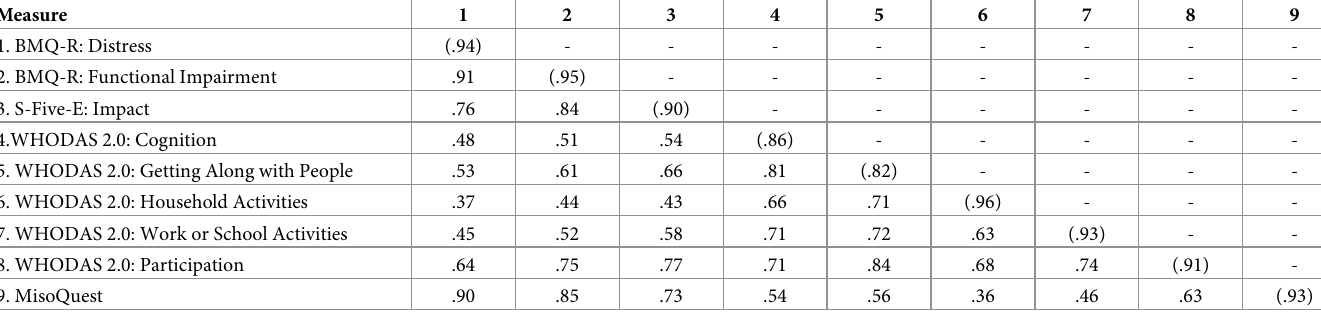
Table 9. Latent intercorrelations for misophonic distress and functional impairment with convergent measures.